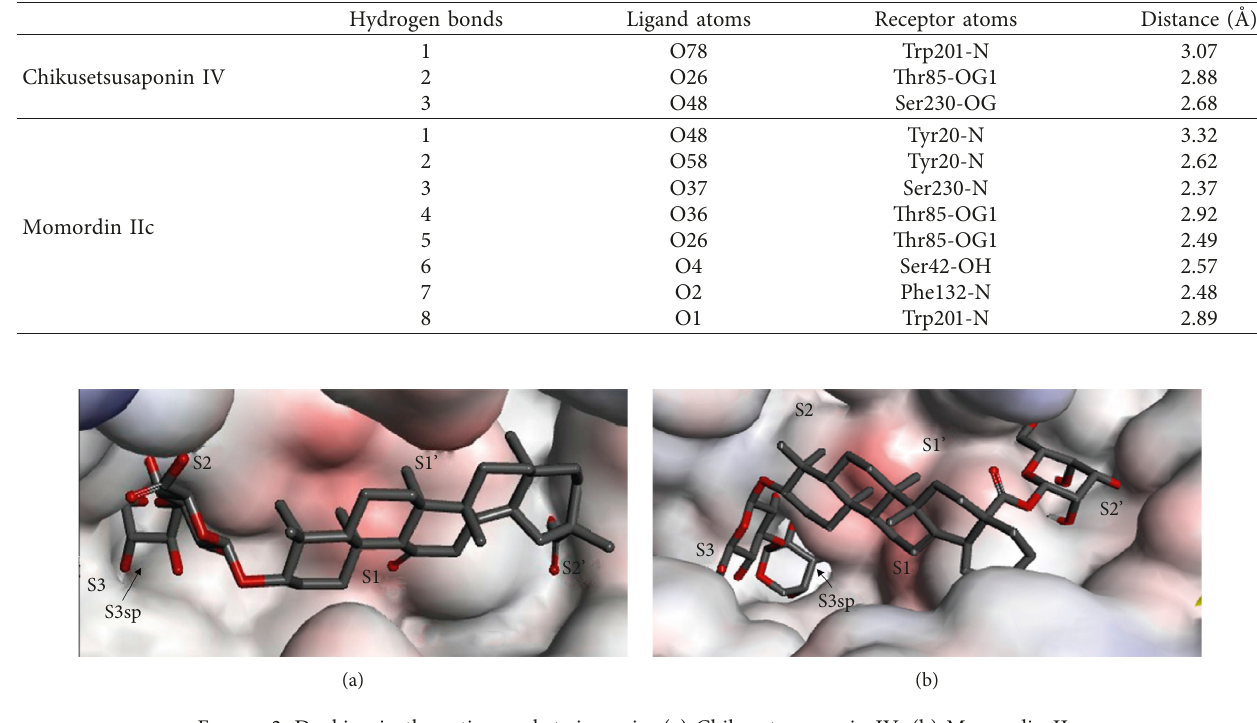
Table 1: The hydrogen bonds in the complexes.